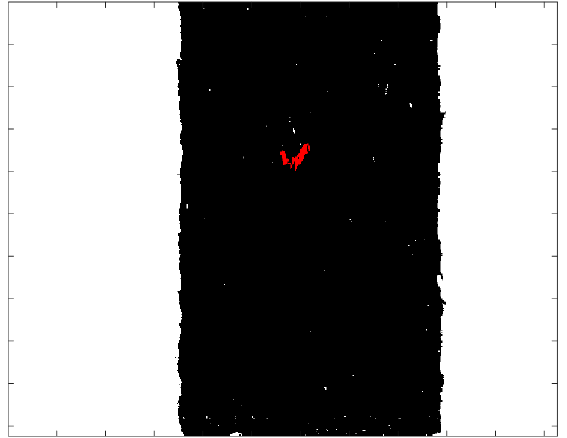
Figure 7. Classification result of the subtraction method.